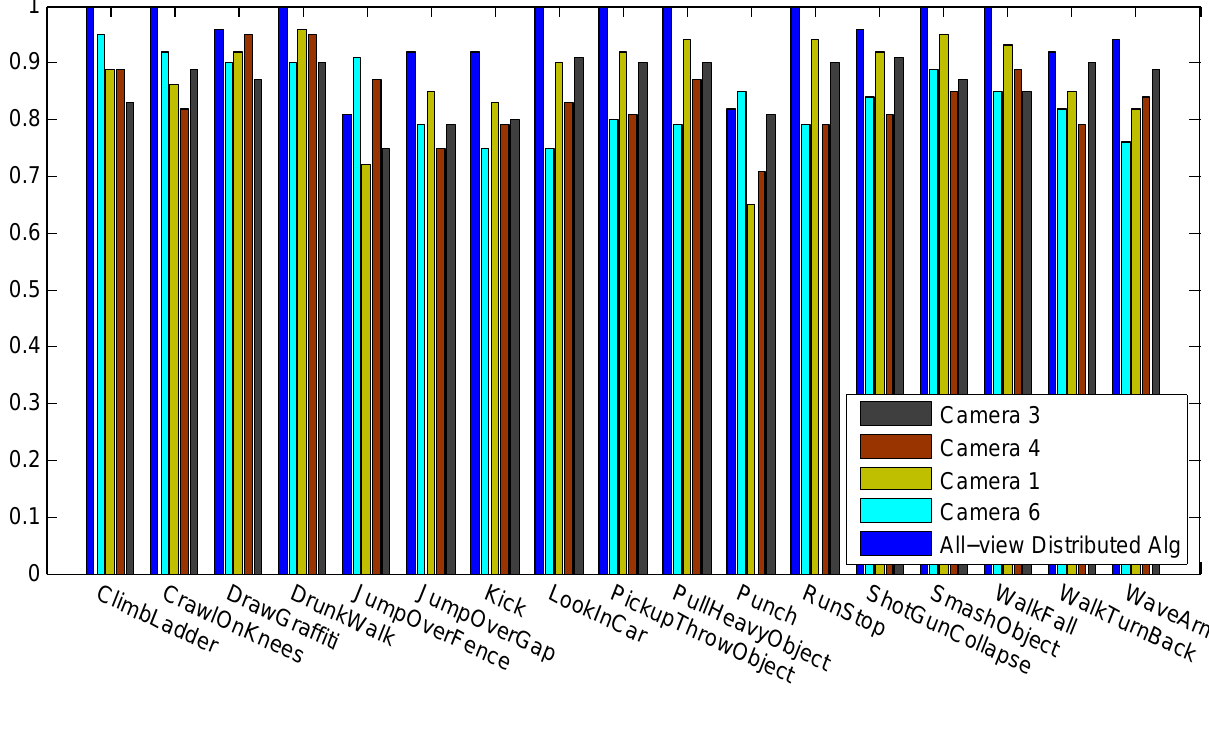
Figure 10. Recognition results for each of the single views and all four views, on the MuHAVi